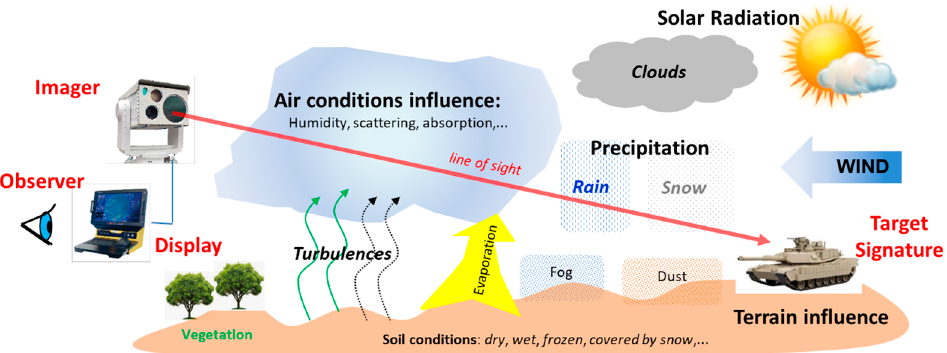
Figure 1. Image forming and perception influences.